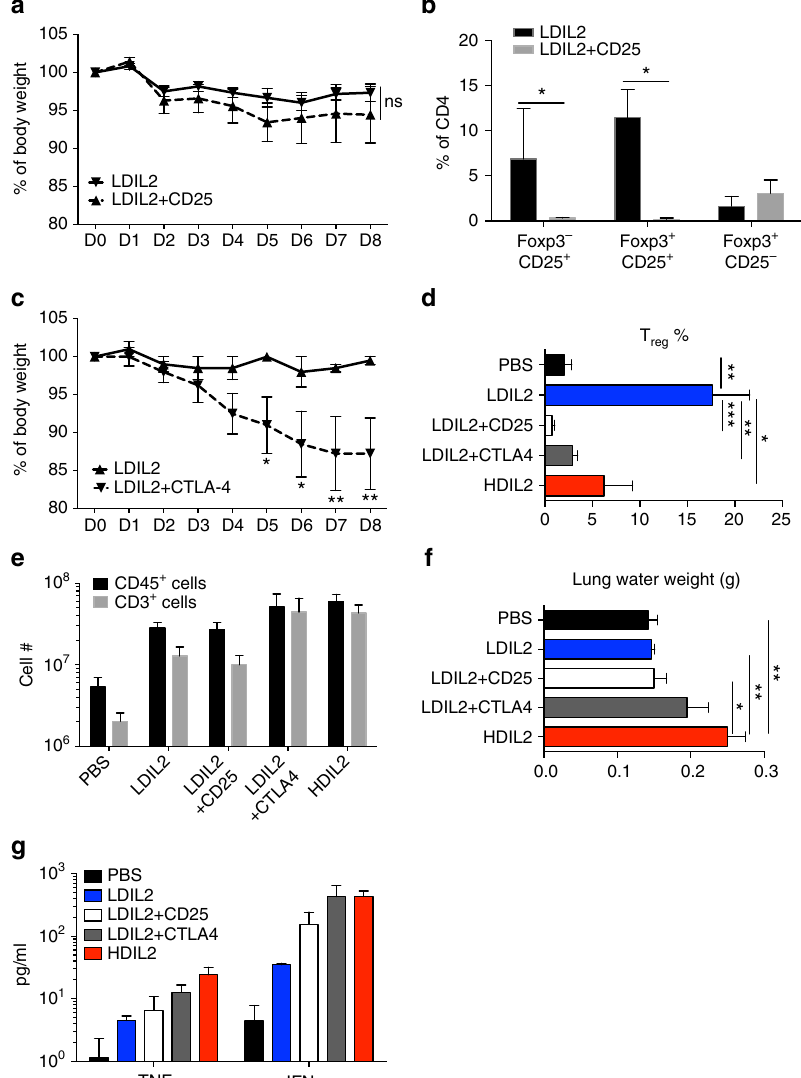
Fig. 5 Regulatory T cell depletion in low-dose IL-2 human immune system induces toxicity. 10 − 14-week-old human immune system (HIS) mice treated with PBS, low-dose IL-2 (LDIL2) or LDIL2 plus anti-CD25 or anti-CTLA-4 depleting mAbs were killed at D8 post injection for analysis. Two injections of 300 μ g anti-CD25 or anti-CTLA-4 depleting mAbs were given at D0 and D4. a , c Percentages of body weight change after LDIL2 treatment and mAb depletion in HIS mice were measured daily ( n = 5 per group). The data are representative of two independent experiments. Comparison is between LDIL2 HIS mice and other groups by repeated-measures two-way ANOVA with a Sidak test. b Percentages of Foxp3 and CD25 expressing cells within splenic CD45 + CD3 + CD4 + T cells. d Percentages of Foxp3 + cells within splenic CD45 + CD3 + CD4 + T cells. e Absolute cell counts of total human CD45 + cells and CD3 + T cells in spleens of indicated groups. f Pulmonary edema in HIS mice were measured by lung water weight. g TNF and IFN- γ levels were analyzed from sera of indicated groups. The data are pooled from two independent experiments and analyzed by 1-way ANOVA test with a Tukey test. * P < 0.05, ** P < 0.01, *** P < 0.001; NS, not signi fi